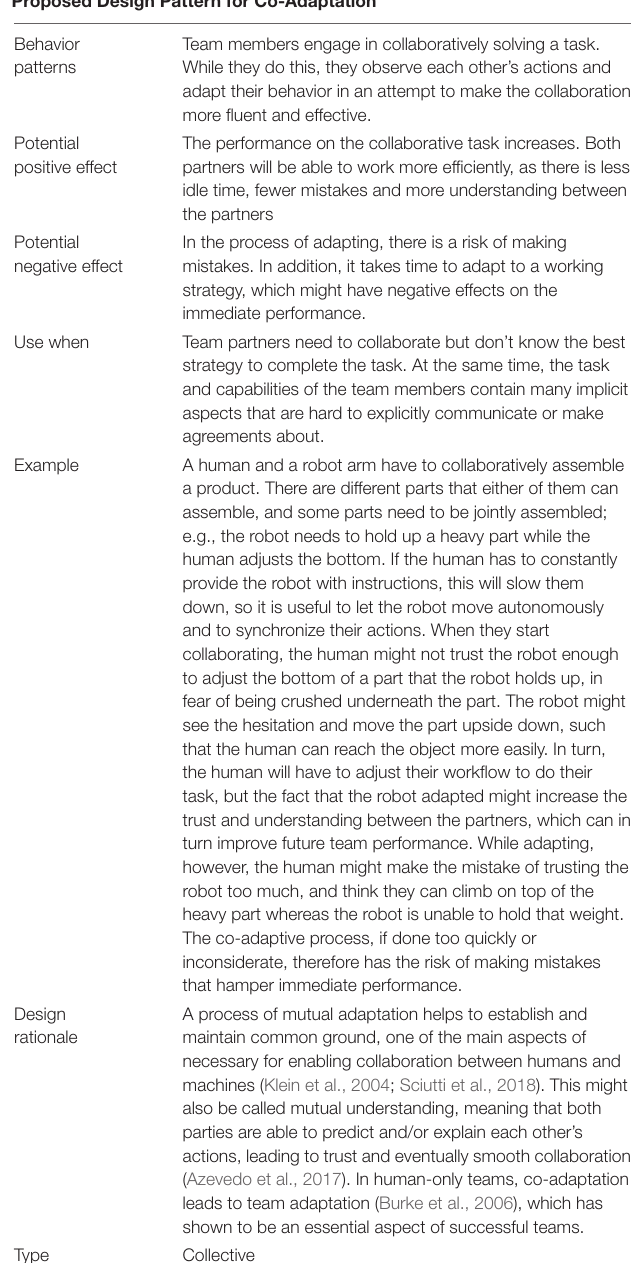
TABLE 1 | Proposed Design Pattern for